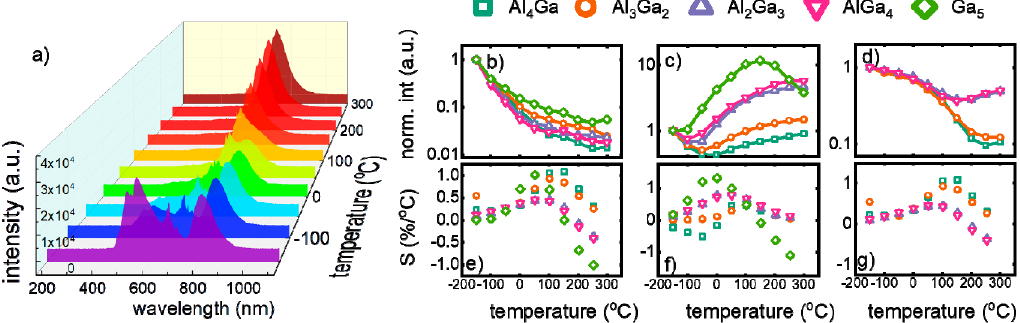
Figure 3. ( a ) Thermal evolution of emission spectrum of Y 3 AlGa 4 O 12 :V nanocrystals; ( b – d ) the influence of local temperature on the emission intensity of V 5 + , V 4 + and V 3 + , respectively; ( e – g ) corresponding relative sensitivities.